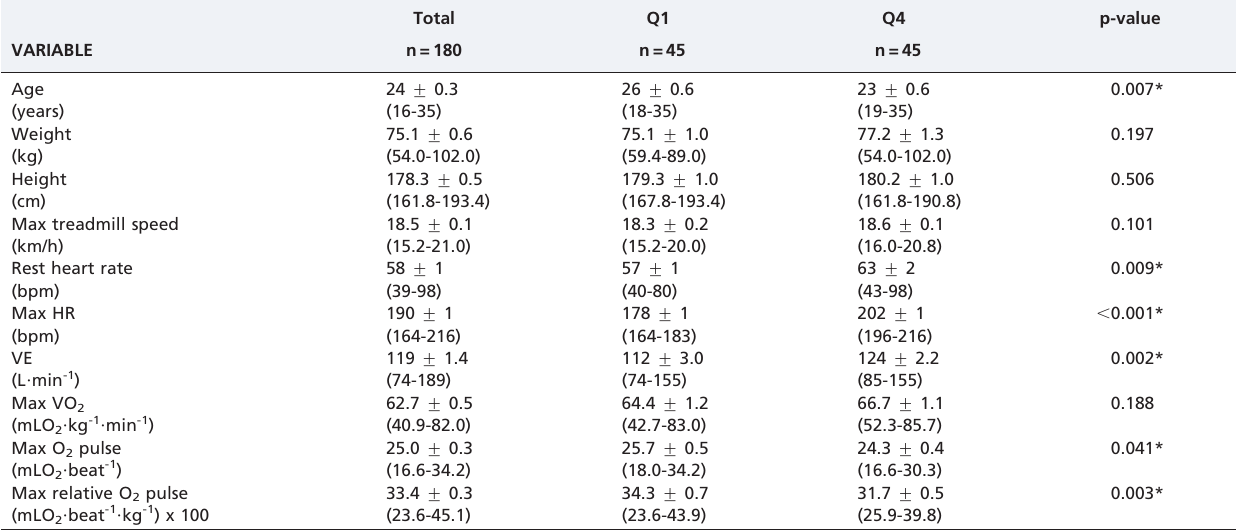
Table 1 - Demographic characteristics and exercise responses during CPET in the entire sample and for the Q1 and Q4